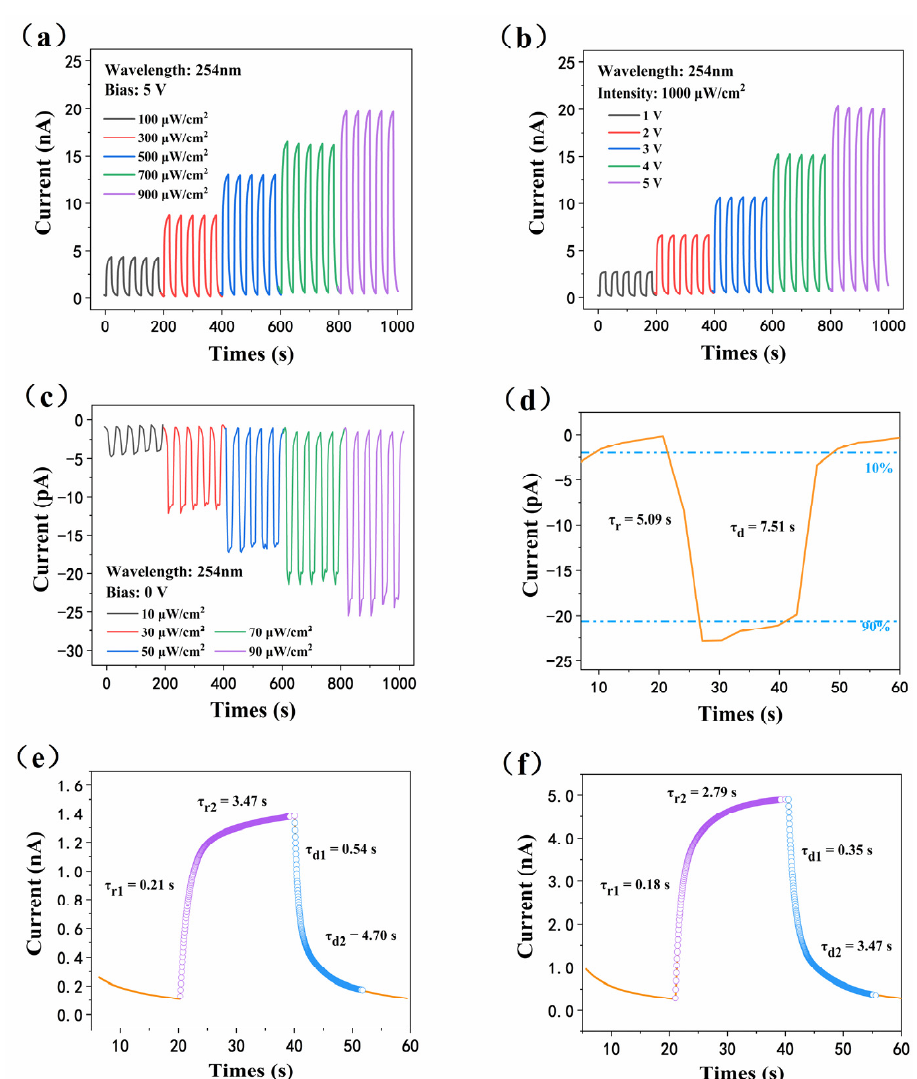
Figure 4. I-t curves of the heterojunction device. ( a ) Various light powers under 5 V, ( b ) various voltages under 1000 μ W/cm 2 , and ( c ) various light powers under 0 V. ( d ) The rise and decay time of the heterojunction device with 90 μ W/cm 2 under 0 V. The rise and decay time of ( e ) Ga 2 O 3 film and ( f ) CoPc/Ga 2 O 3 heterojunction with 300 μ W/cm 2 under 3 V.